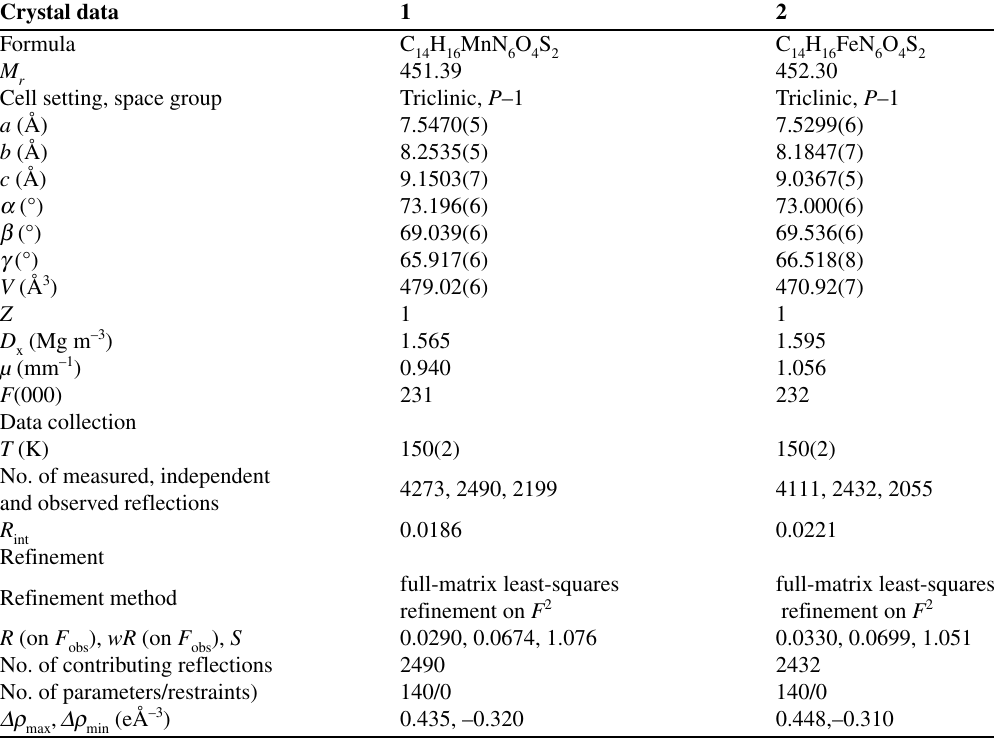
Table 1. Crystal data, data collection and structure refinement. Crystal